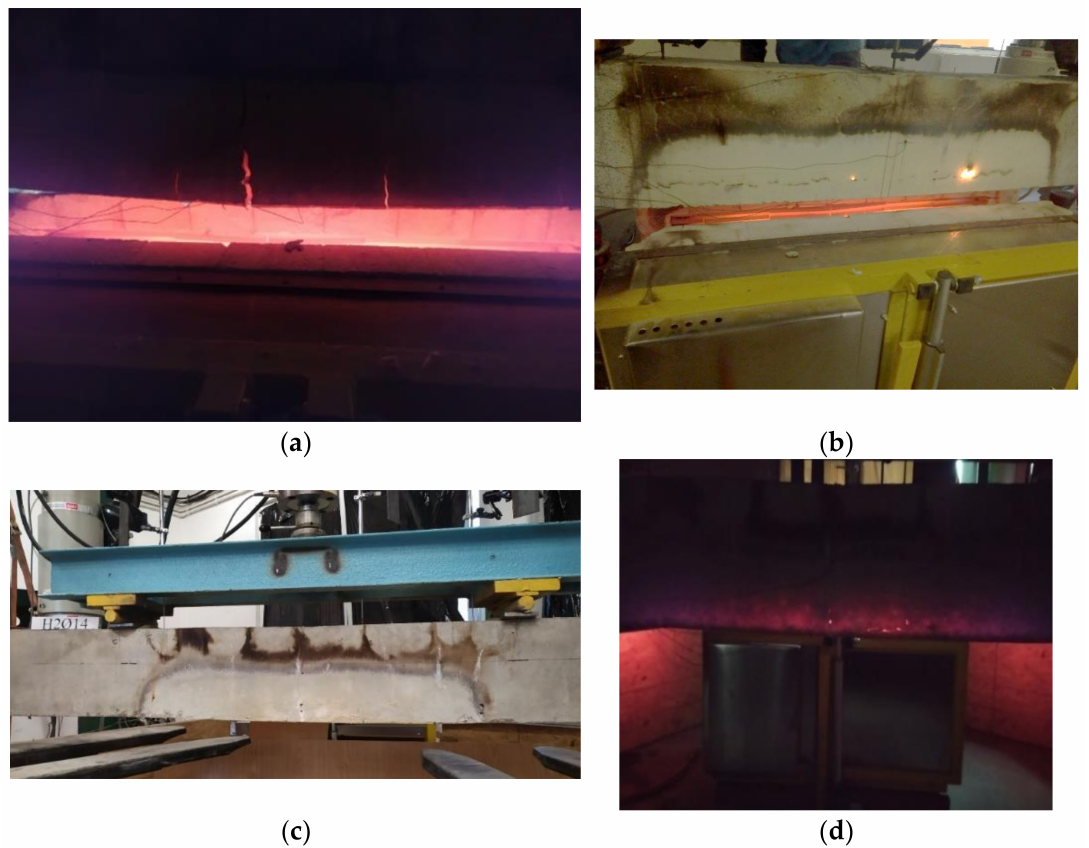
Figure 4. Samples just after being taken out of furnace: ( a ) set 1.1 B2Ø14; ( b ) set 1-prev B2Ø14; ( c ) set